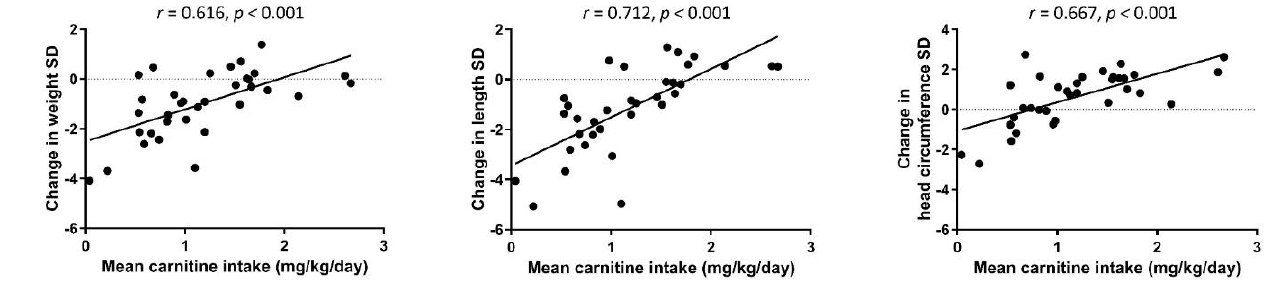
Figure 2. Spearman rank correlations between mean daily carnitine intake (mg/kg) of weeks 1 and 5, and weight, length, and head circumference Z-score change from birth to TEA.